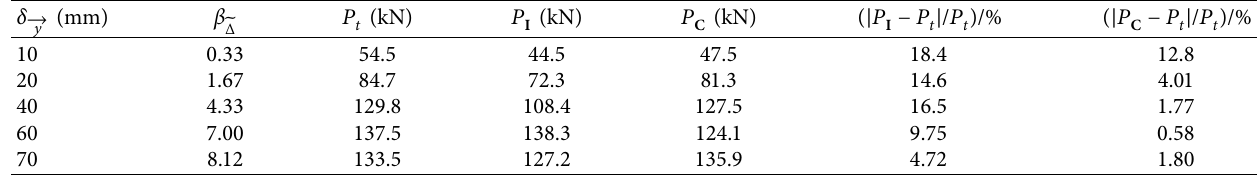
p + and the comparisons between